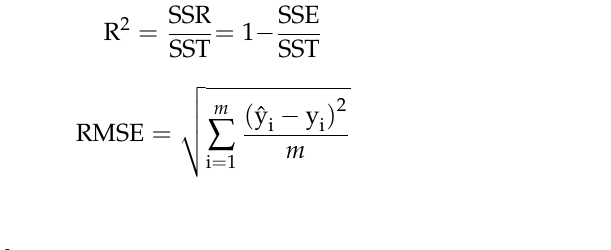
Table 2. Soil organic matter content in the study area.